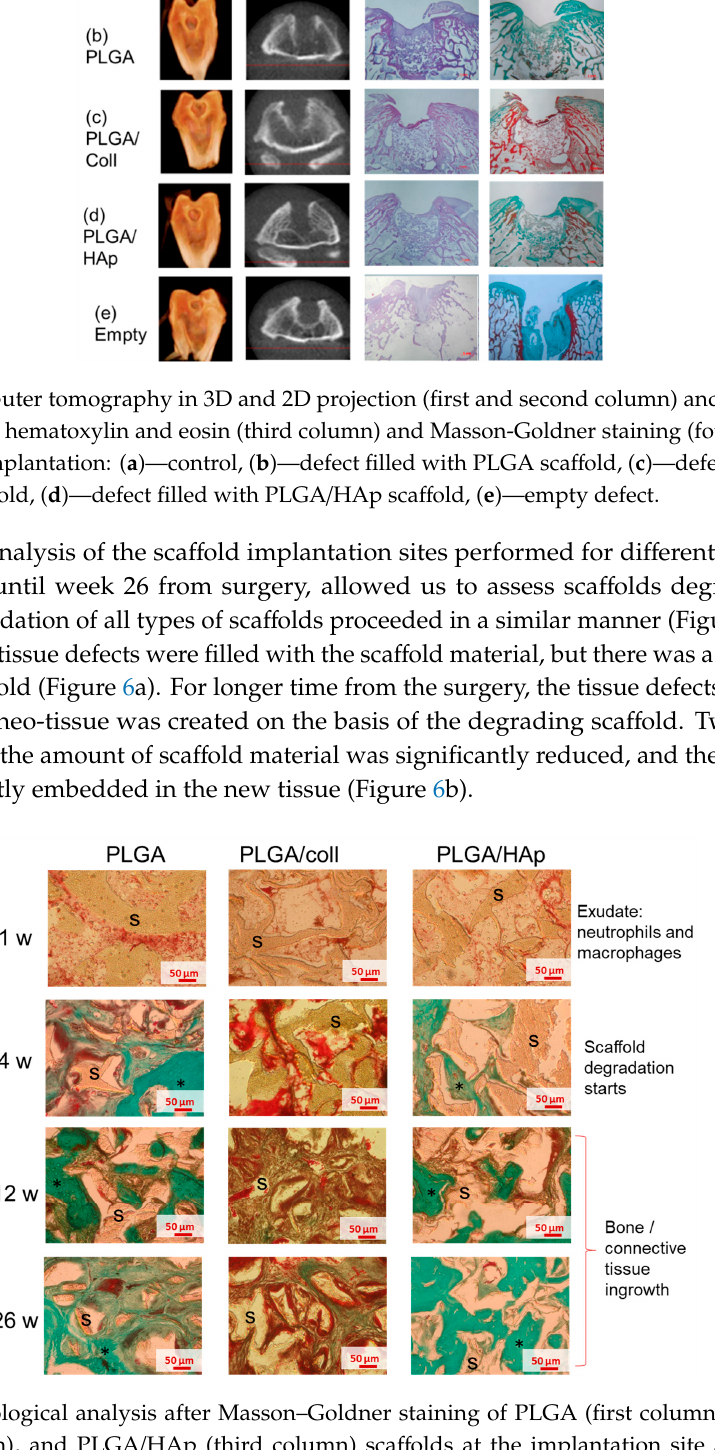
Figure 5. Histological analysis after Masson – Goldner staining of PLGA (first column), PLGA/coll (second column), and PLGA/HAp (third column) scaffolds at the implantation site after 1 week (first panel), 4 weeks (second panel), 12 weeks (third panel), and 26 weeks (fourth panel) post-implantation; s — scaffold, star (*) — tissue ingrowth. The pictures were taken in the central part of the defect filled with the scaffold.